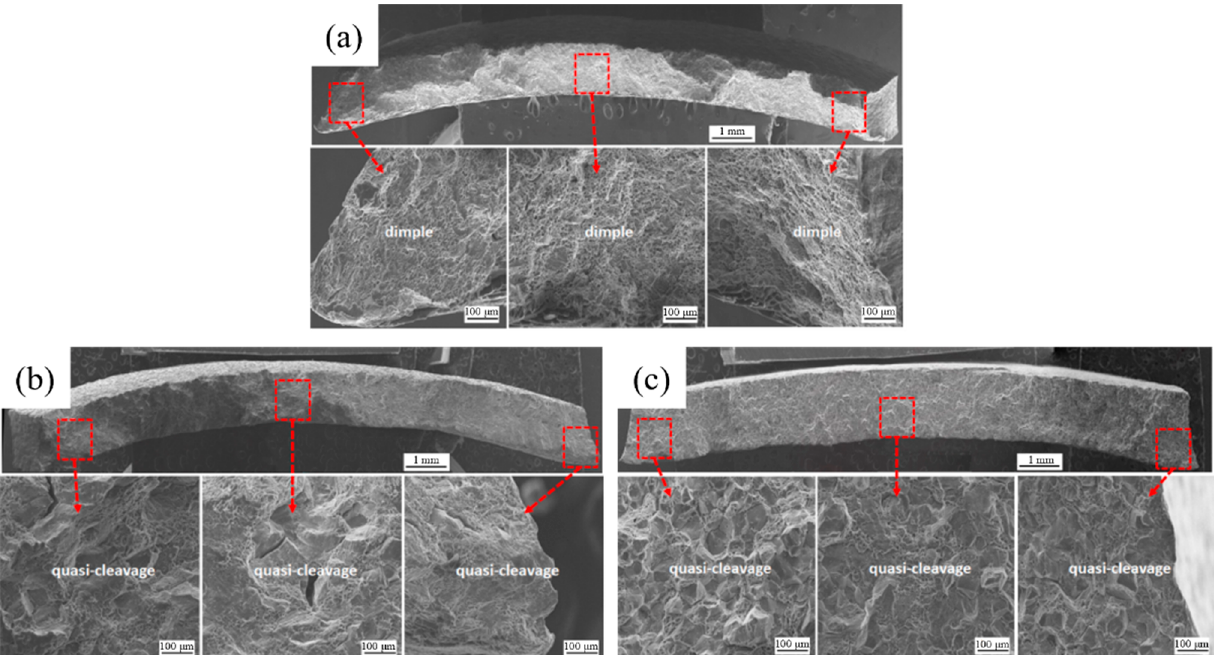
Figure 6. Fracture surface morphology of tensile specimen with different irradiation fluence: ( a ) unirradiated specimen; ( b ) irradiation fluence of 0.54 × 10 21 n/cm 2 ; ( c ) irradiation fluence of 2.38 × 10 22 n/cm 2 .